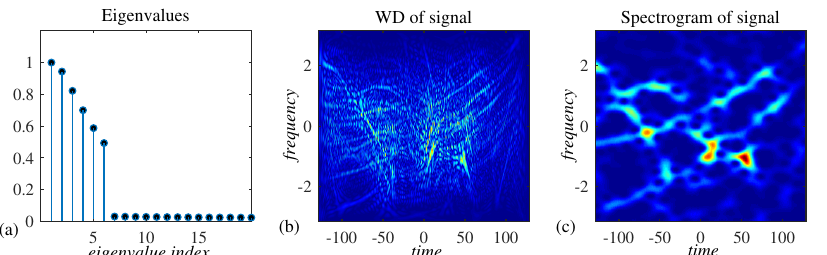
Figure 11. ( a ) Eigenvalues of autocorrelation matrix R , ( b ) Wigner distribution of the signal from Example 3, and ( c ) Spectrogram of the signal from Example 3. Signal consists of P = 6 non-stationary components. The signal is embedded in an intensive complex, Gaussian, zero-mean noise with σ ε = 1. The number of channels is C = 256. The largest six eigenvalues correspond to the signal